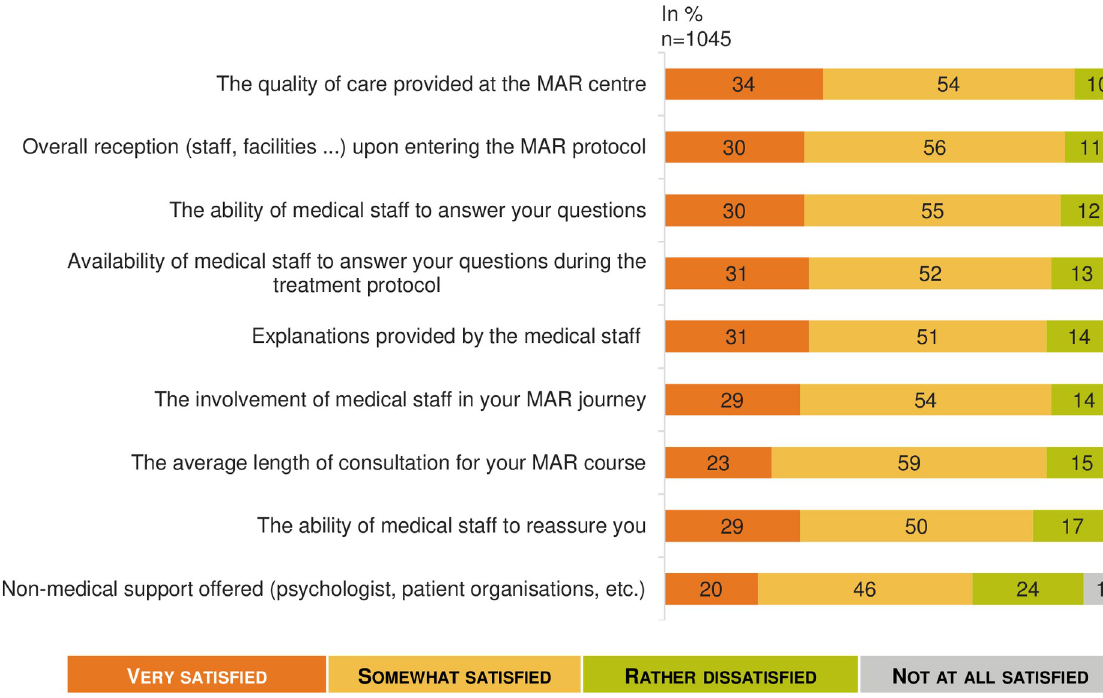
Fig 1. Satisfaction concerning health care during the MAR program: A French national survey. Percentage of answers to the question “Would you say that you have been very, somewhat, rather not or not at all satisfied with the following as part of your MAR program?” (n = 1